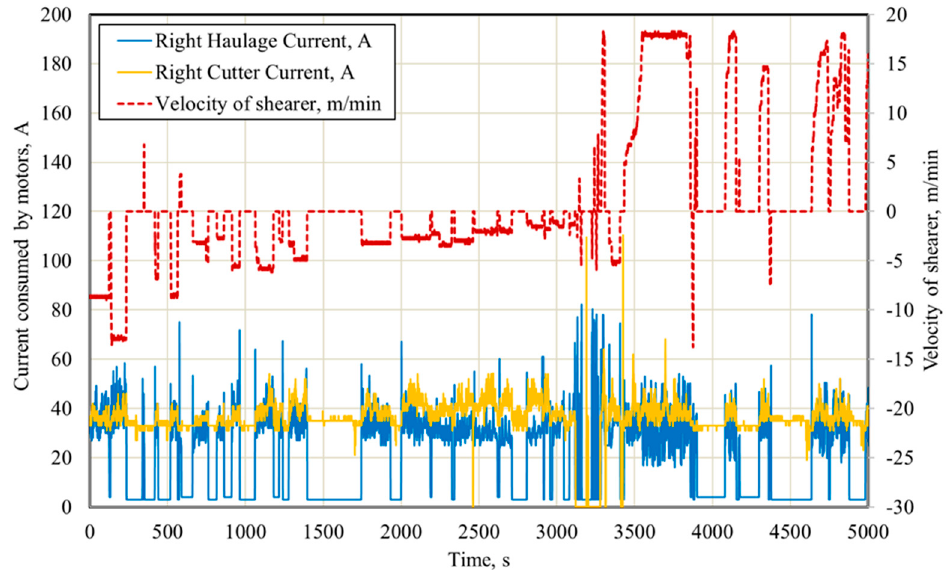
Figure 6. Time waveforms of the shearer loader’s speed and the intensities of currents consumed by the right motors of the shearer’s arm and feed.